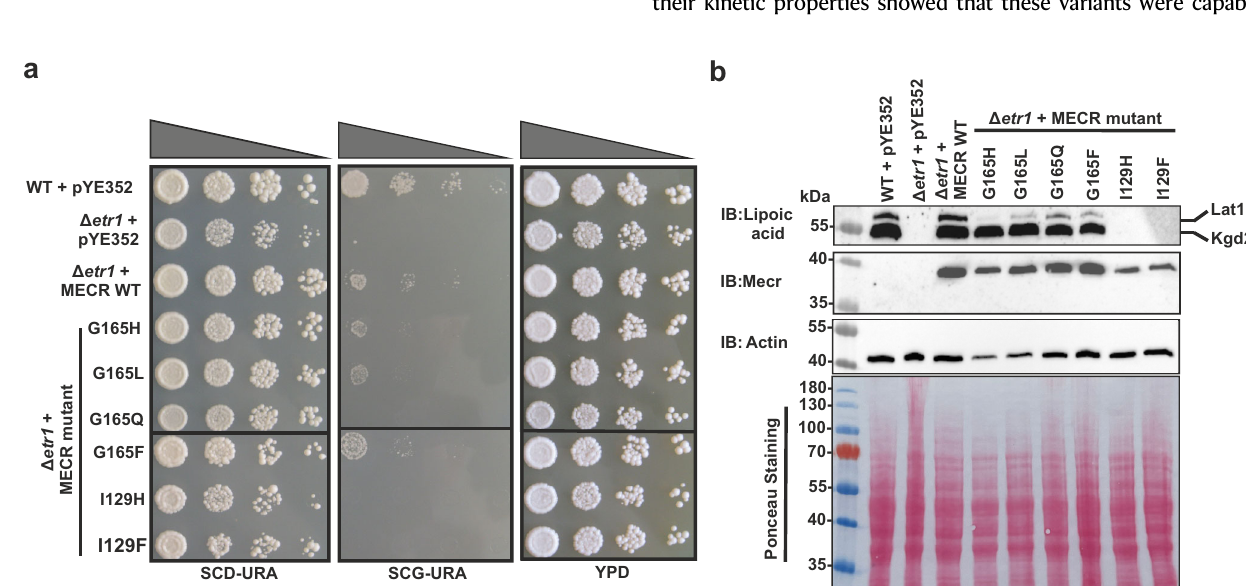
Fig. 3 | In vivo screening of human MECR mutants in yeast. a Ten-fold dilution series testing for growth of wild-type and mutated human MECR variants on glu- cose (SCD-URA and YPD) and glycerol (SCG-URA) growth media. First row: Wild- type Bj1991 α yeast strain with empty vector pYE352, Second row: Null mutant ( Δ etr1 ) Bj1991 α yeast strain with empty vector pYE352, third row: Bj1991 α Δ etr1 yeast strain with mitochondrially targeted MECR in pYE352, fourth row to nineth